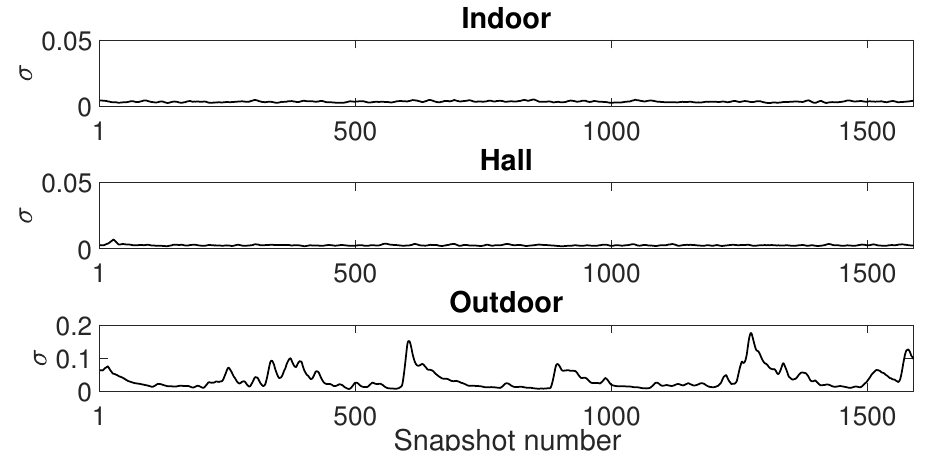
Figure 20. Gaussian model estimation: Sample window of 1500 with 10% of windows overlapping.